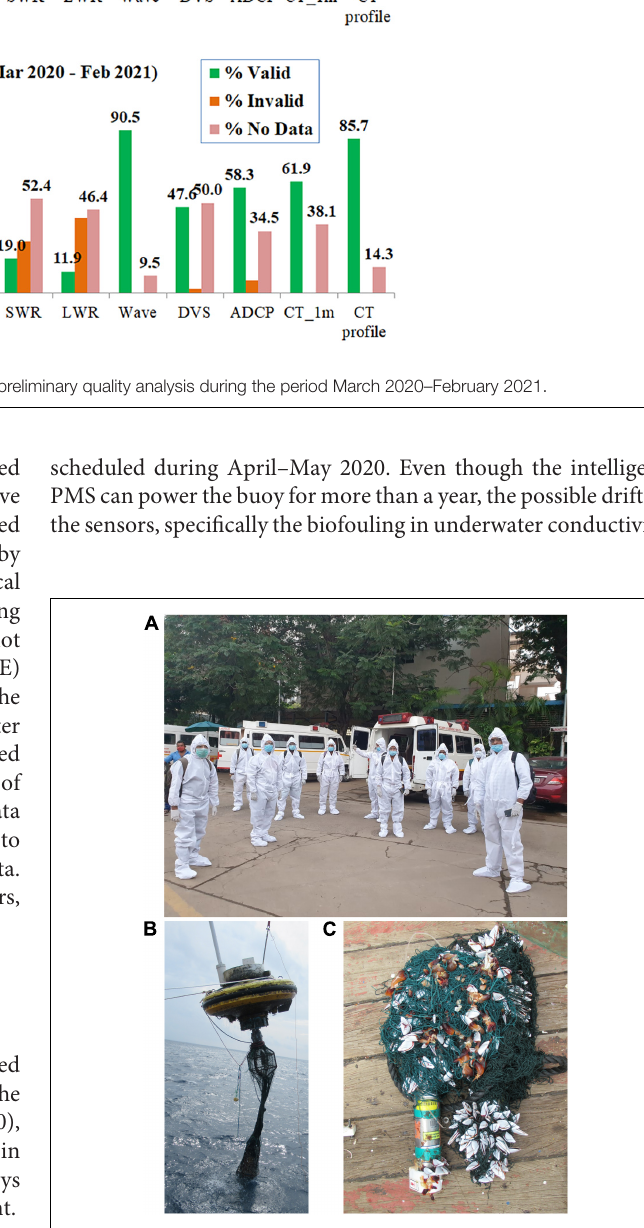
FIGURE 6 | (A) The team proceeding for the cruise, (B) the retrieval of the buoy system entangled with fishing net, and (C) the bio-fouling and net entanglement in retrieved